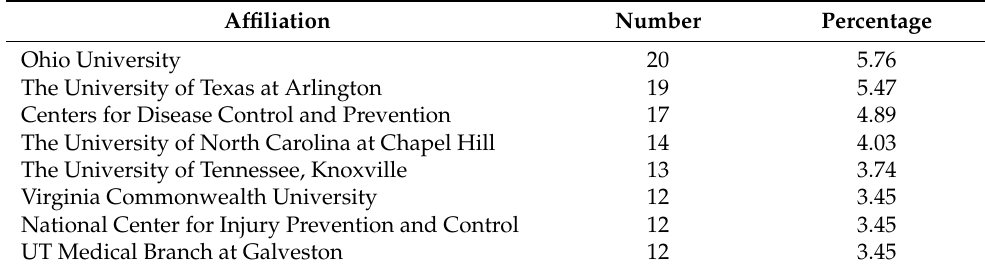
Table 2. Number of documents according to affiliation found in the Scopus database.